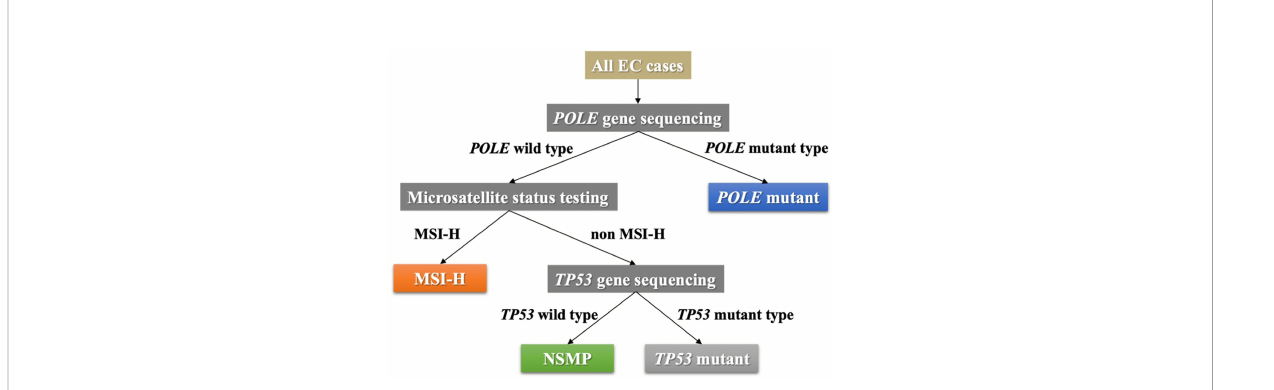
FIGURE 1 The pipeline of molecular subtyping of EC. EC, endometrial cancer; MSI-H, microsatellite instability high; NSMP, no speci fi c molecular pro fi